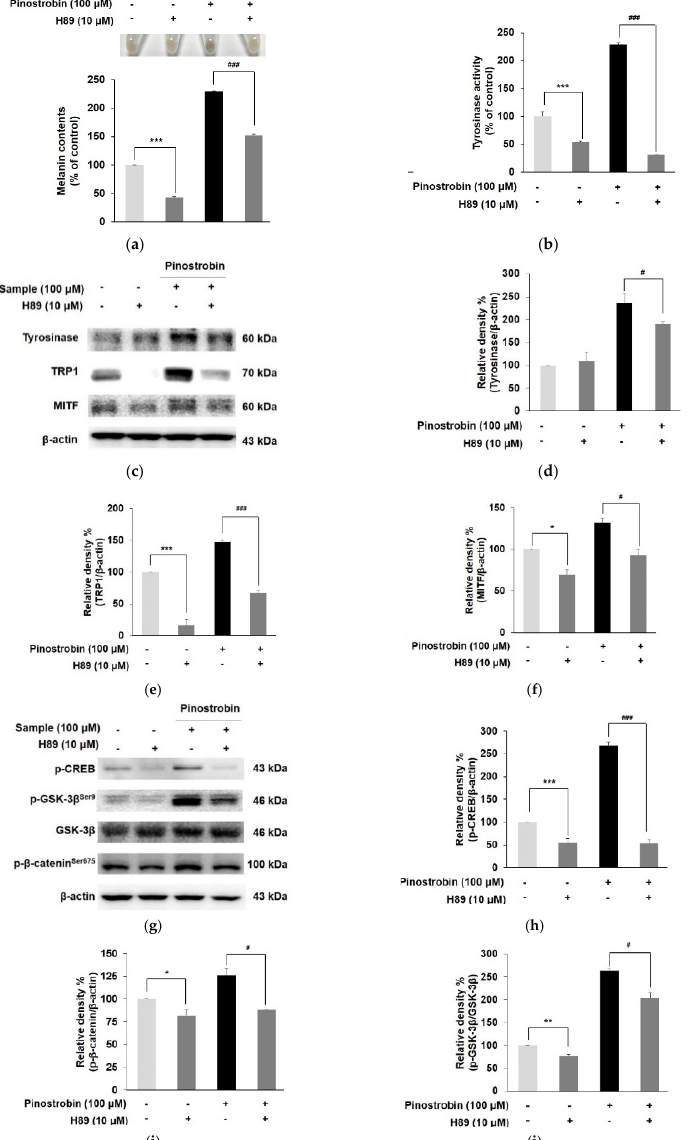
Figure 4. Effect of pinostrobin and H89 (PKA inhibitor) on PKA signaling pathway in B16F10 cells. Cells were pre − treated with H89 for 30 min prior to exposure to pinostrobin (100 µM) for 72 h to evaluate ( a ) the intracellular melanin contents, and ( b ) tyrosinase activity. ( c − f ) Cells were treated with H89 (10 µM) for 30 min, followed by treatment with pinostrobin (100 µM) for 24 h. Subse- quently, tyrosinase, TRP 1, and MITF were analyzed by Western blotting. ( g − j ) Western blotting result of p − CREB, p − GSK − 3 β , and p −β -catenin expression with co-treatment of H89 and pinostrobin. Blots were quantified using ImageJ software. Protein levels were normalized to the corresponding loading controls. The untreated cells were regarded as 100%. Values are expressed represent as the mean±SD of three independent experiments. *** p < 0.001, ** p < 0.01, and * p < 0.05 compared with control group; ### p < 0.001 and # p < 0.05 compared with pinostrobin group without H89. 3.5. Pinostrobin Regulated p38 and ERK Signaling Pathway MAPKs were demonstrated as one of the upstream pathways of melanogenesis by regulating MITF activation [14]. The phosphorylation of p38, ERK, and JNK was evalu- ated to elucidate the mechanism underlying the MITF-mediated melanogenesis property of pinostrobin. As shown in Figure 5a–c, the levels of p38 phosphorylation were remark- ably elevated, while the ERK phosphorylation was significantly reduced in pinostrobin- treated cells as compared to those of the control. However, the compound had no effect on phosphorylated JNK (Figure 5a,d). These results indicated that both p38 activation and ERK suppression were partly related to melanogenesis by pinostrobin.